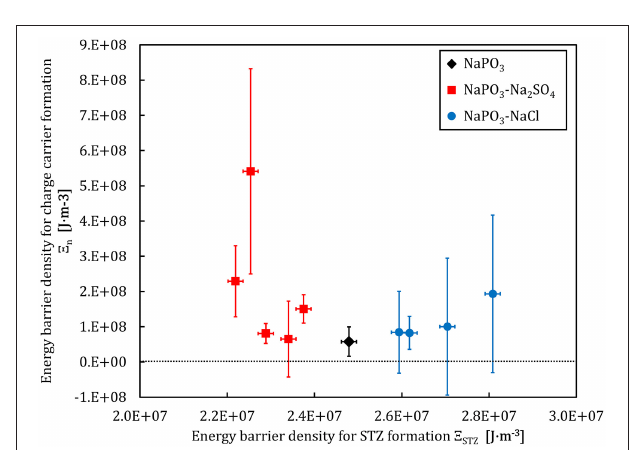
FIGURE 12 | Charge carrier formation energy barrier density and the STZ formation energy barrier density derived from experimental data for the NaPO 3 -NaCl-Na 2 SO 4 glass